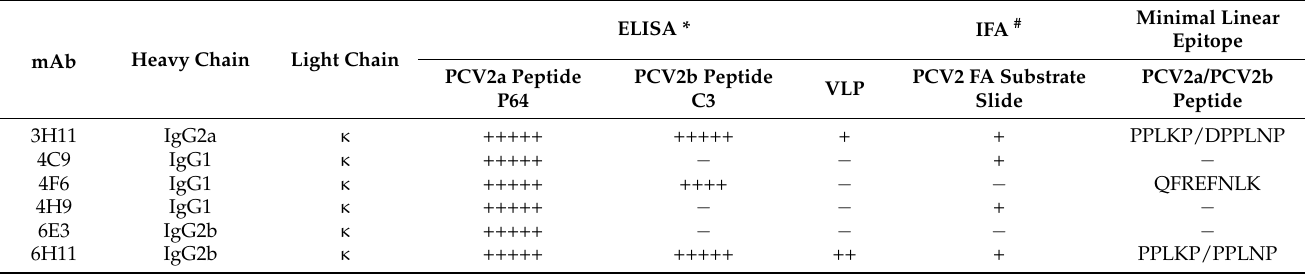
Table 3. Characterization of mAbs against the peptide